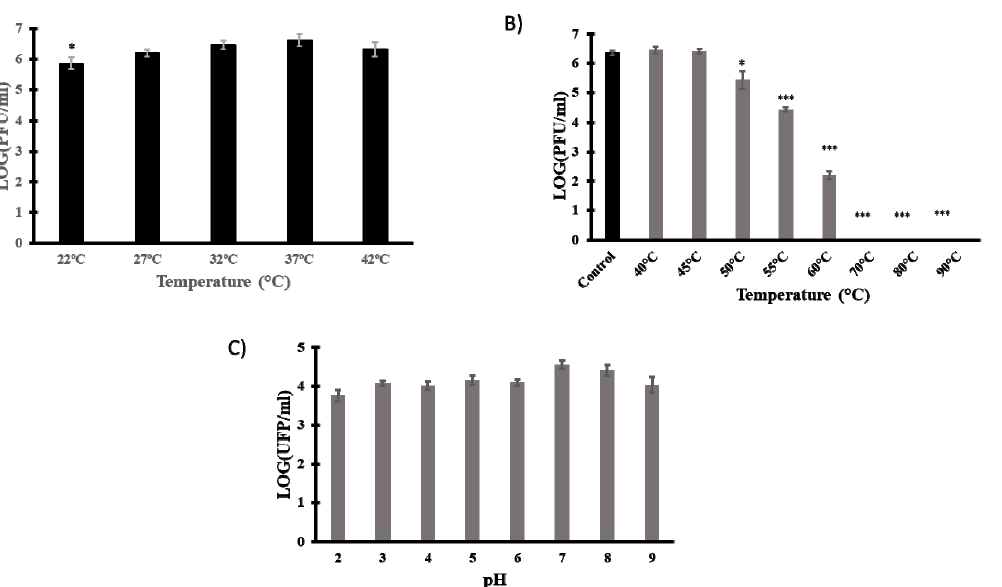
Figure 5. Technological characterisation of phage vB_EfmH_163. The effect of incubation temperature